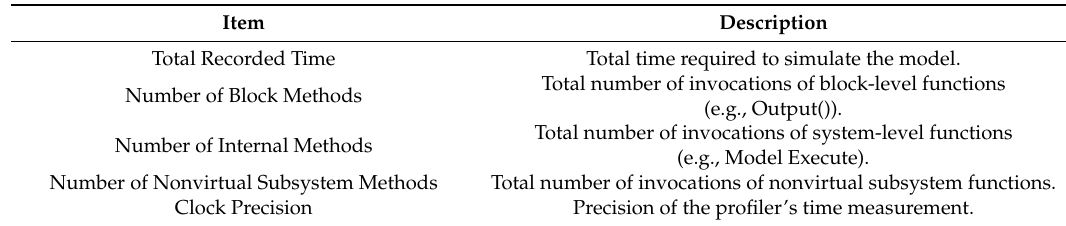
Table 4. Description of the fields in the